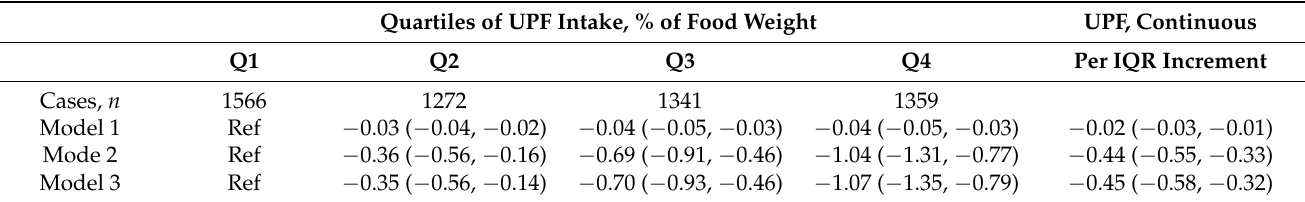
Table 3. Regression estimates and 95% CI of eGFR by quartiles and per IQR of UPF intake.